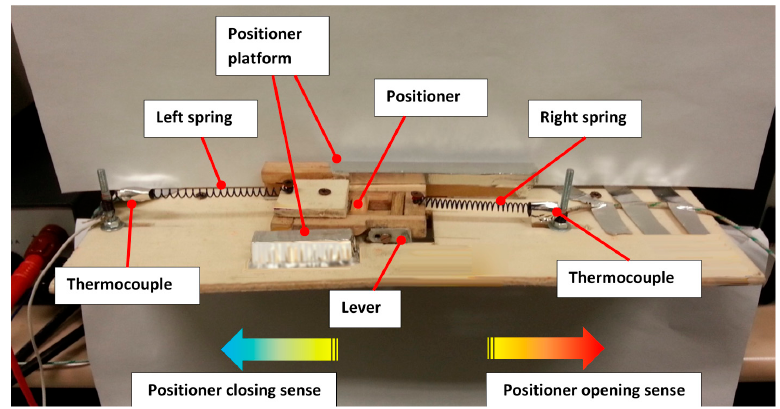
Figure 11. Prototype main components.